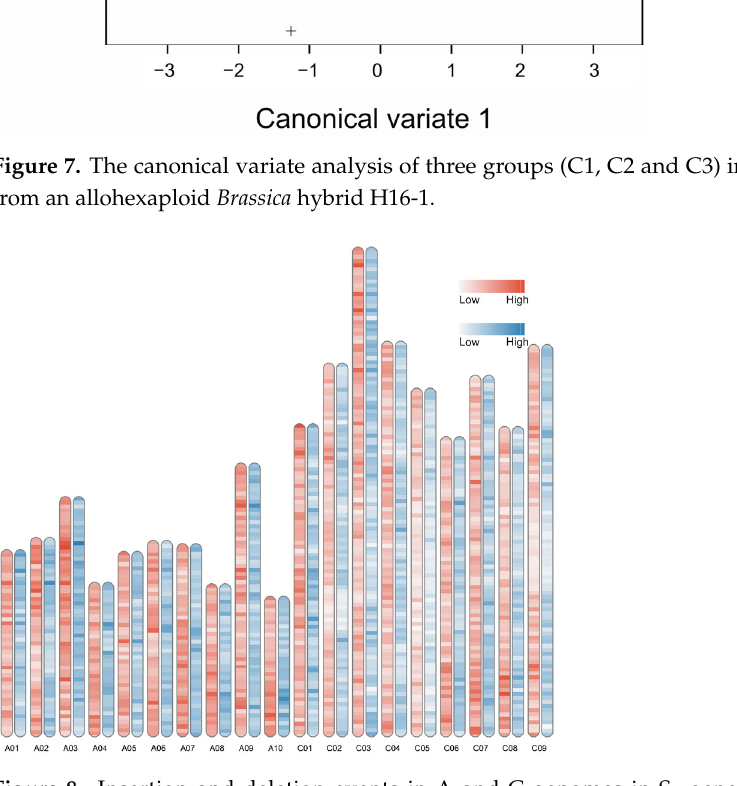
Figure 8. Insertion and deletion events in A and C genomes in S 2 generation derived from an allohexaploid Brassica hybrid H16-1. Red color represents insertion events and bule color represents deletion events. The darker the color, the higher the frequency, and vice versa.